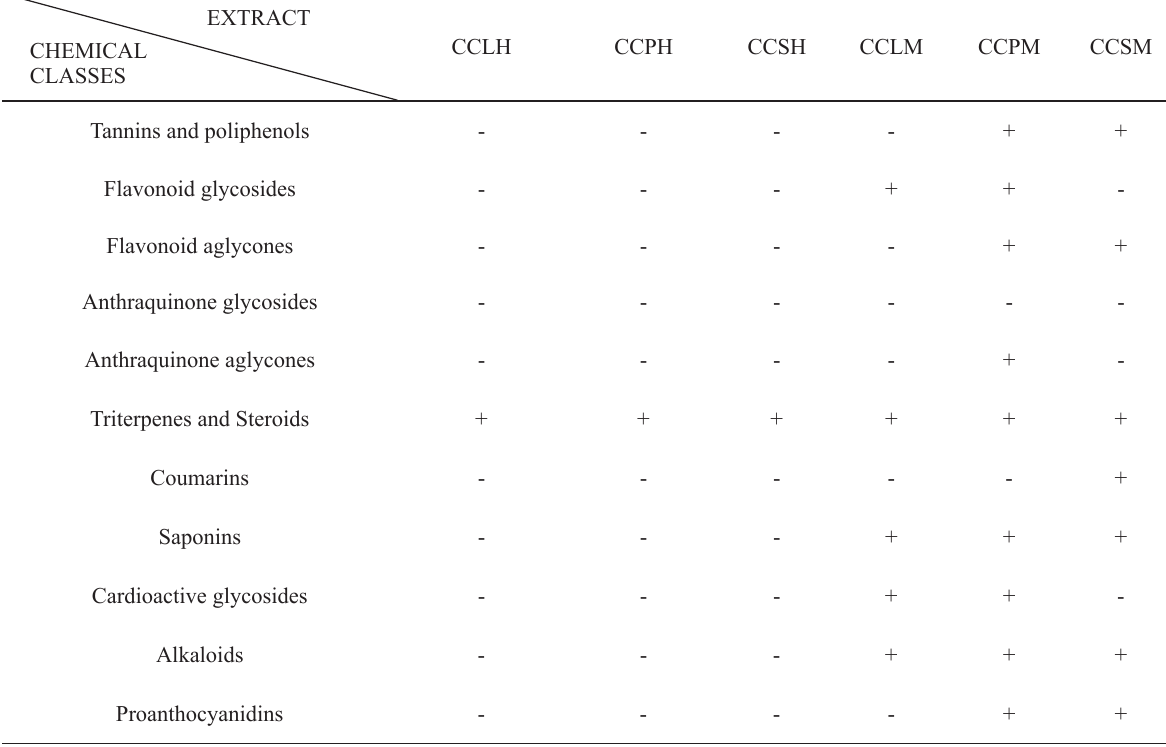
Detection of different chemical classes of extracts of C. criuva by